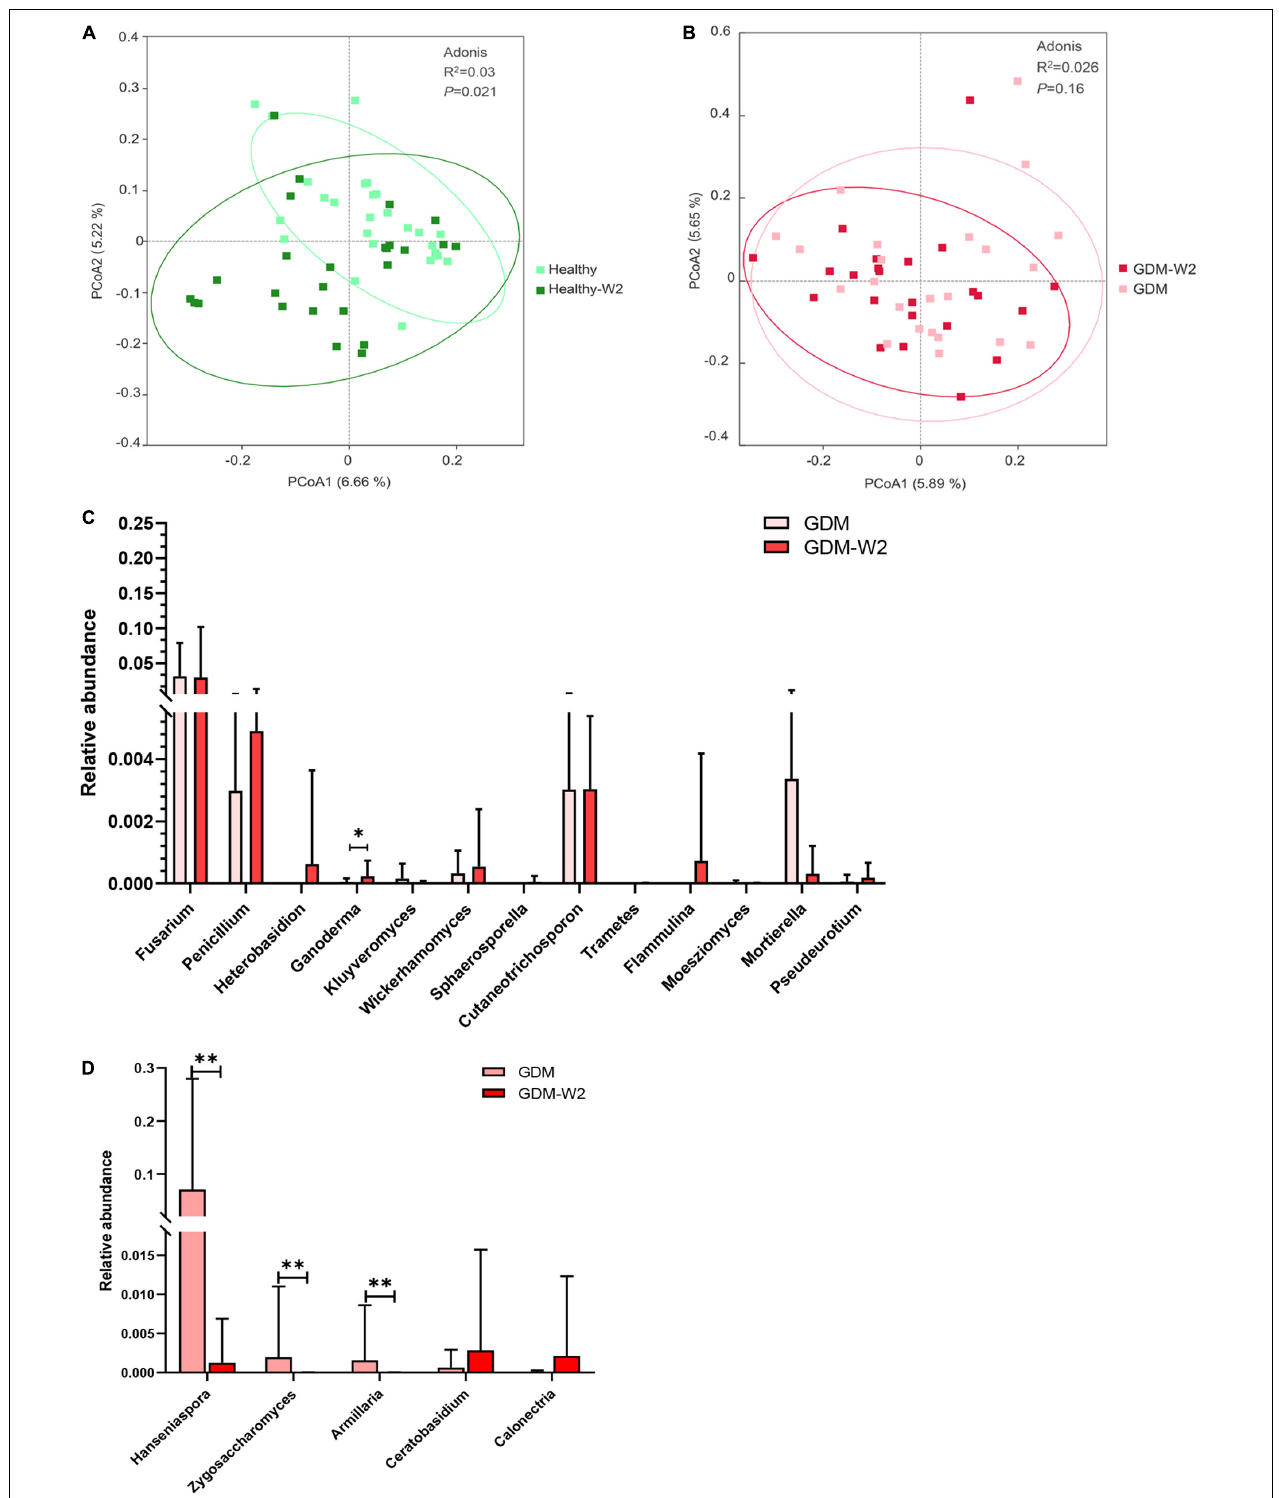
FIGURE 4 | The microbial pattern between two time points. (A) Principal coordinate analysis (PCoA) at the OTU level between the healthy and healthy-W2 groups ( n = 26). (B) Principal coordinate analysis (PCoA) at the OTU level between the GDM and GDM-W2 groups ( n = 23). (C) Relative abundance of probiotic genera, in the GDM samples with or without diet intervention. Mann-Whitney test. (D) Relative abundance of genera positively related with metabolic scores, in the GDM samples with or without diet intervention. Mann-Whitney test, ∗∗ P < 0.01, ∗ P < 0.05.